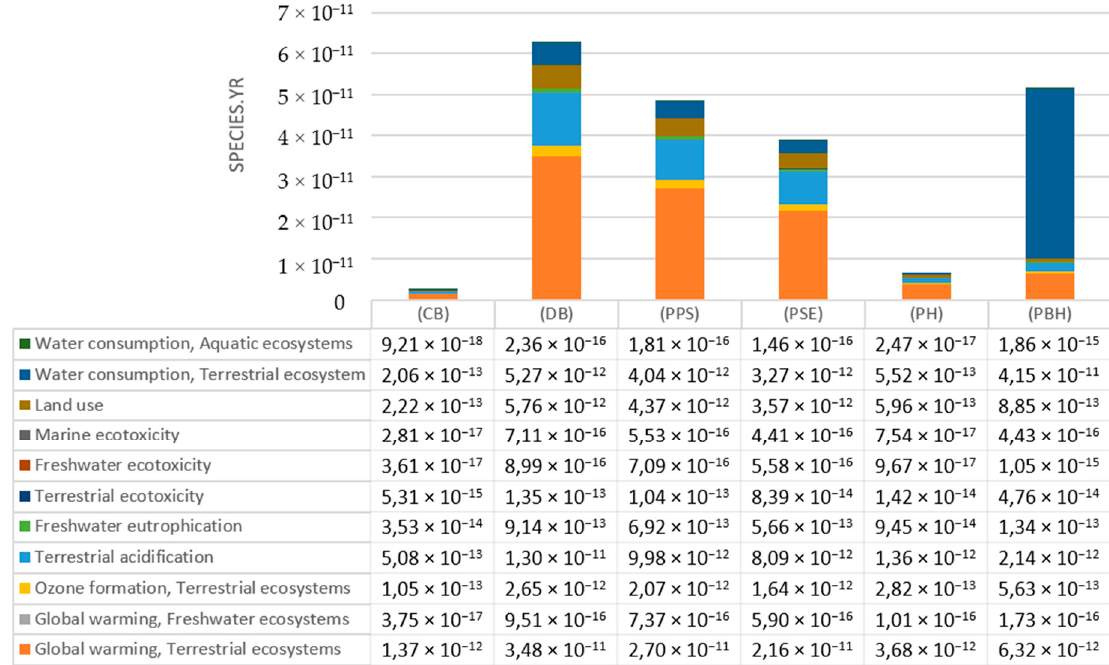
Figure 10. Results of environmental impact characterization for 11 categories of ecosystem shaping. Table 8. Results of environmental impacts characterization for the category of global warming. land ecosystems (species.yr).